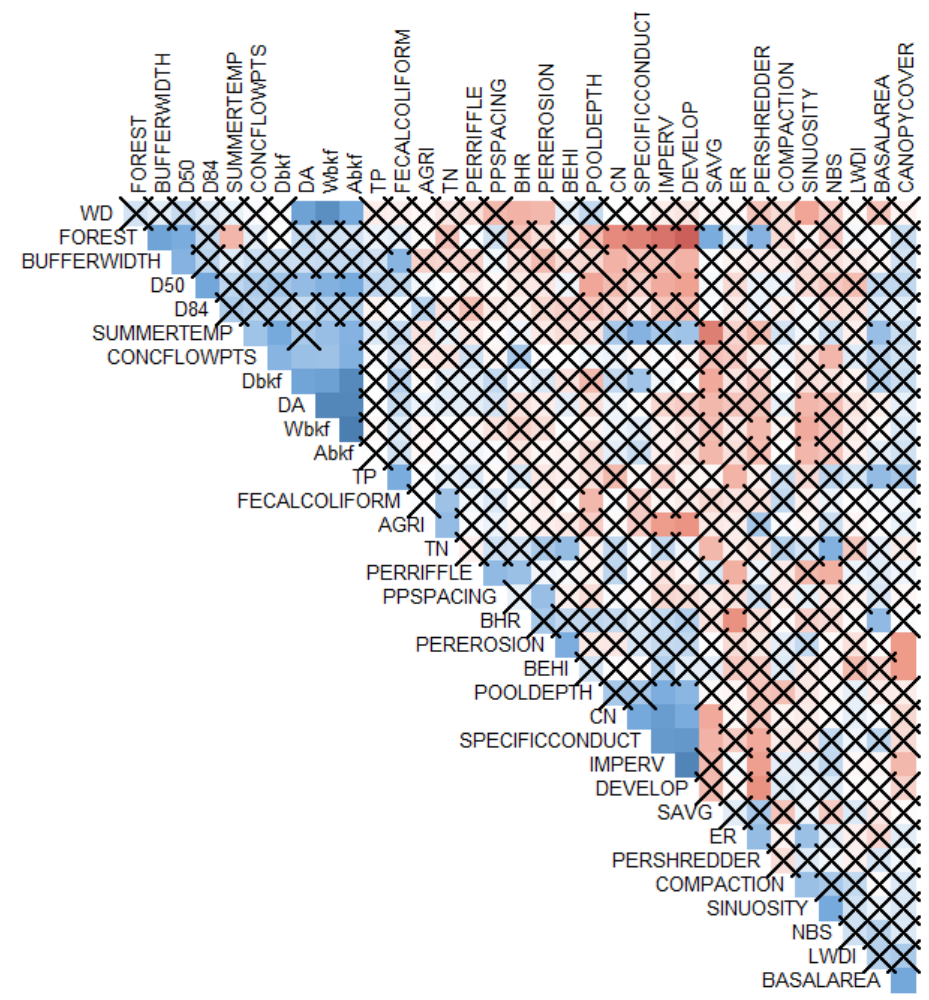
Figure A1. Correlation matrix for the SQT + dataset, where insignificant pairwise correlations at the α = 0.05 level are demarcated with an “x.” Red indicates negative pairwise correlations and blue indicates positive pairwise correlations along a color gradient, whereby the correlation coefficient increases as the red and blue colors darken.